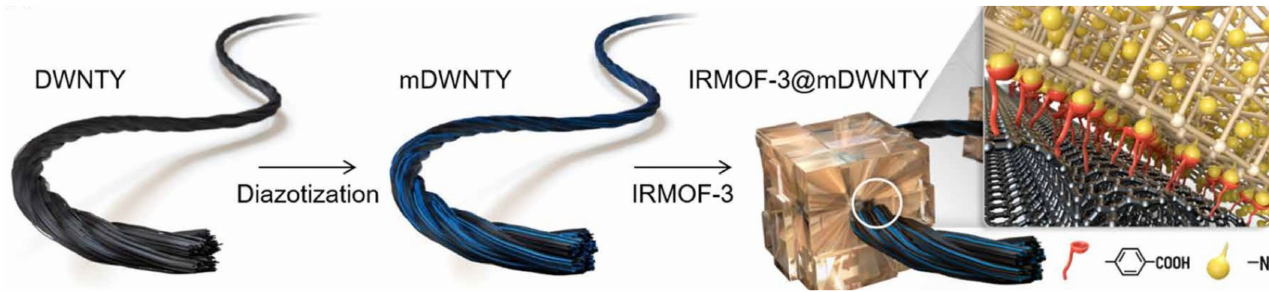
Figure 18. Schematics illustrating the synthesis process used to fabricate IRMOF3@mDWNTY (IRMOF3 = ligand-based isoreticular metal–organic framework; mDWNTY = modified double-walled nanotube yarn). Reprinted with permission from